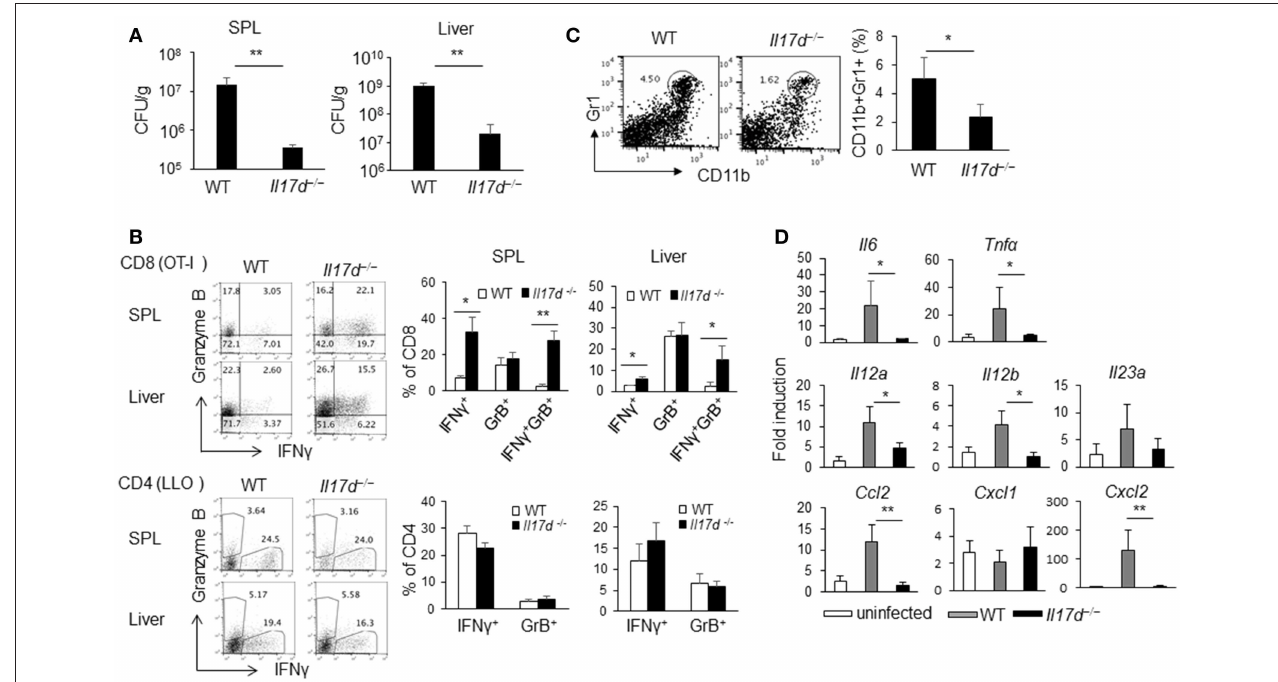
FIGURE 2 | IL-17D promotes chronicity of LM-OVA infection in mice. (A) WT ( n = 5) or Il17d − / − mice ( n = 5) were intravenously infected with 1 × 10 4 LM-OVA on day 0, and the mice were analyzed on day 7. Livers and spleens were collected, homogenized, and counted for bacterial burden by serial dilution on BHI agar after overnight incubation. (B) CD4 or CD8T cells isolated from spleen and liver and re-stimulated with specific peptide (1 µ g/ml of LLO peptide for CD4, 1 µ g/ml of OT1 peptide for CD8) for overnight. IFN γ and granzyme B production in CD4 and CD8T cells analyzed by intracellular staining. (C) CD11b + Gr1 + cells in the spleen were stained by FACS. (D) Molecular analysis by RT-PCR in the liver. Data are representative of at least five independent experiments. * p ≤ 0.05, ** p ≤ 0.01.